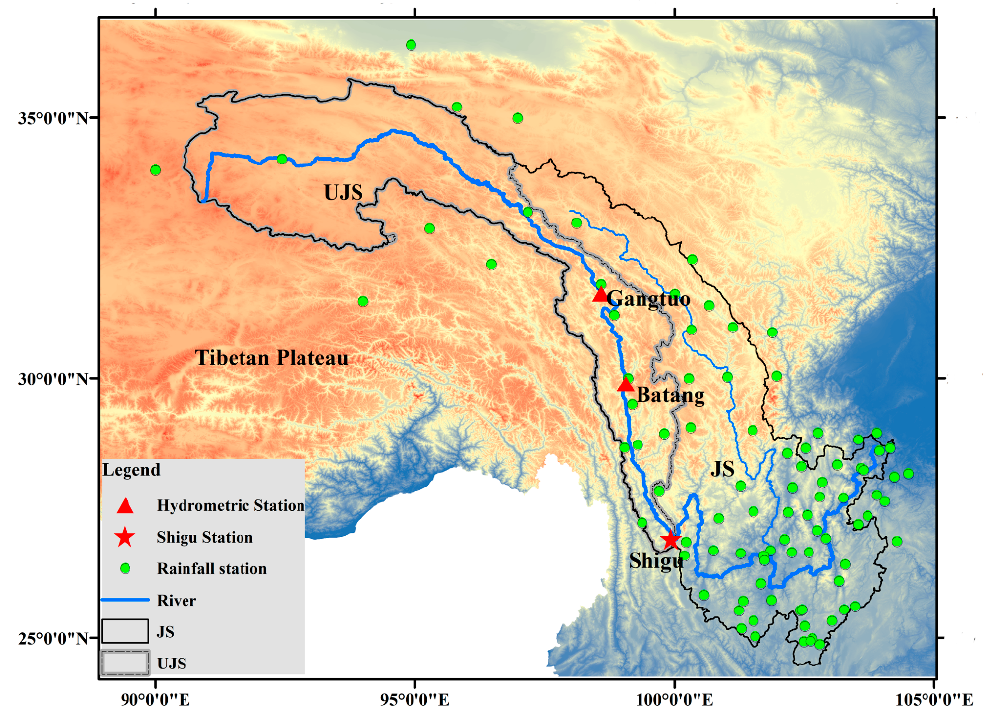
Figure 1. Distribution of rainfall stations in the Jinsha River Basin (JS means the Jinsha River Basin, UJS means the upper reaches of Jinsha River Basin).